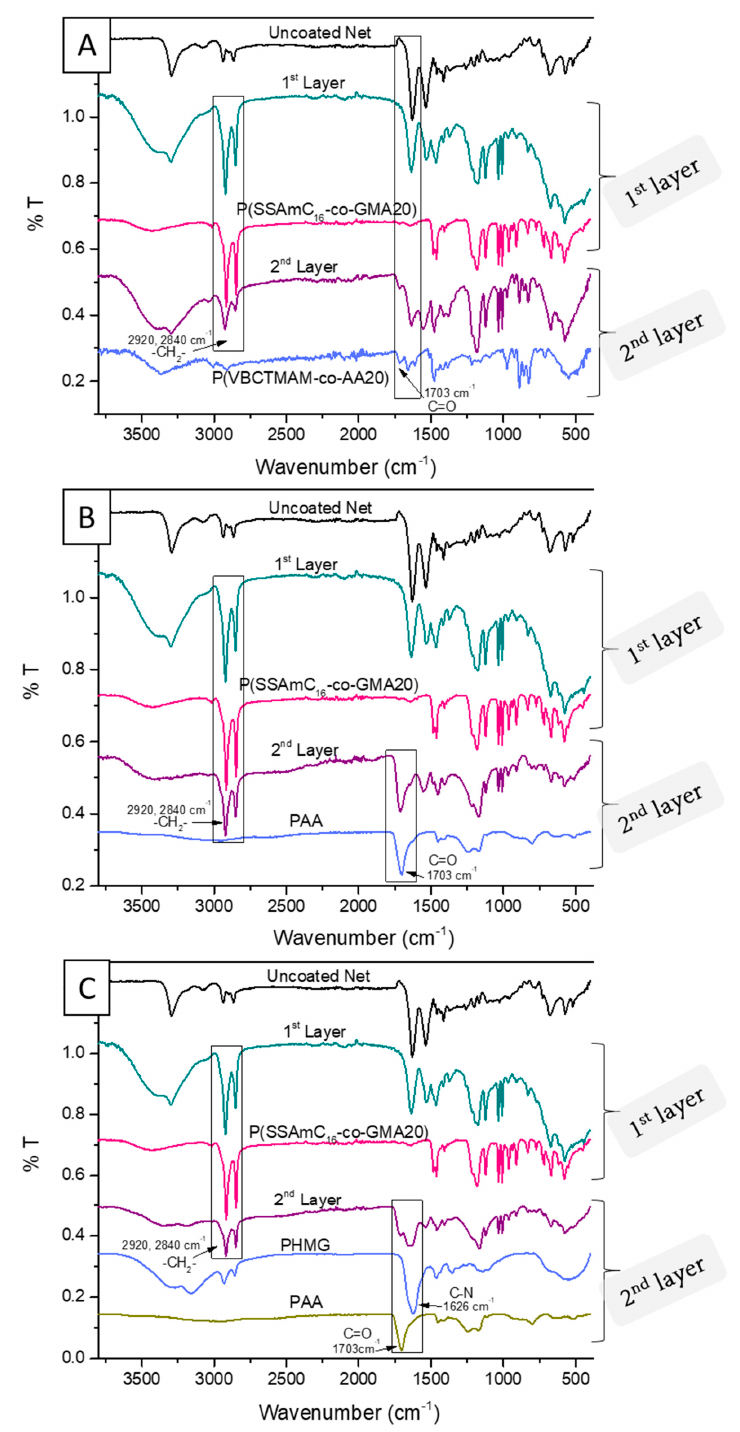
Figure 4. ATR-FTIR spectra of coated nets with CN1 ( A ), CN2 ( B ) and CN3 ( C ). The spectra of the individual polymers as well as the uncoated net are also shown for comparison.